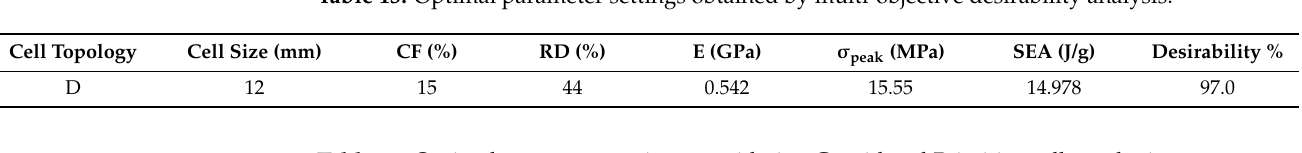
Table 14. Optimal parameter settings considering Gyroid and Primitive cell topologies.